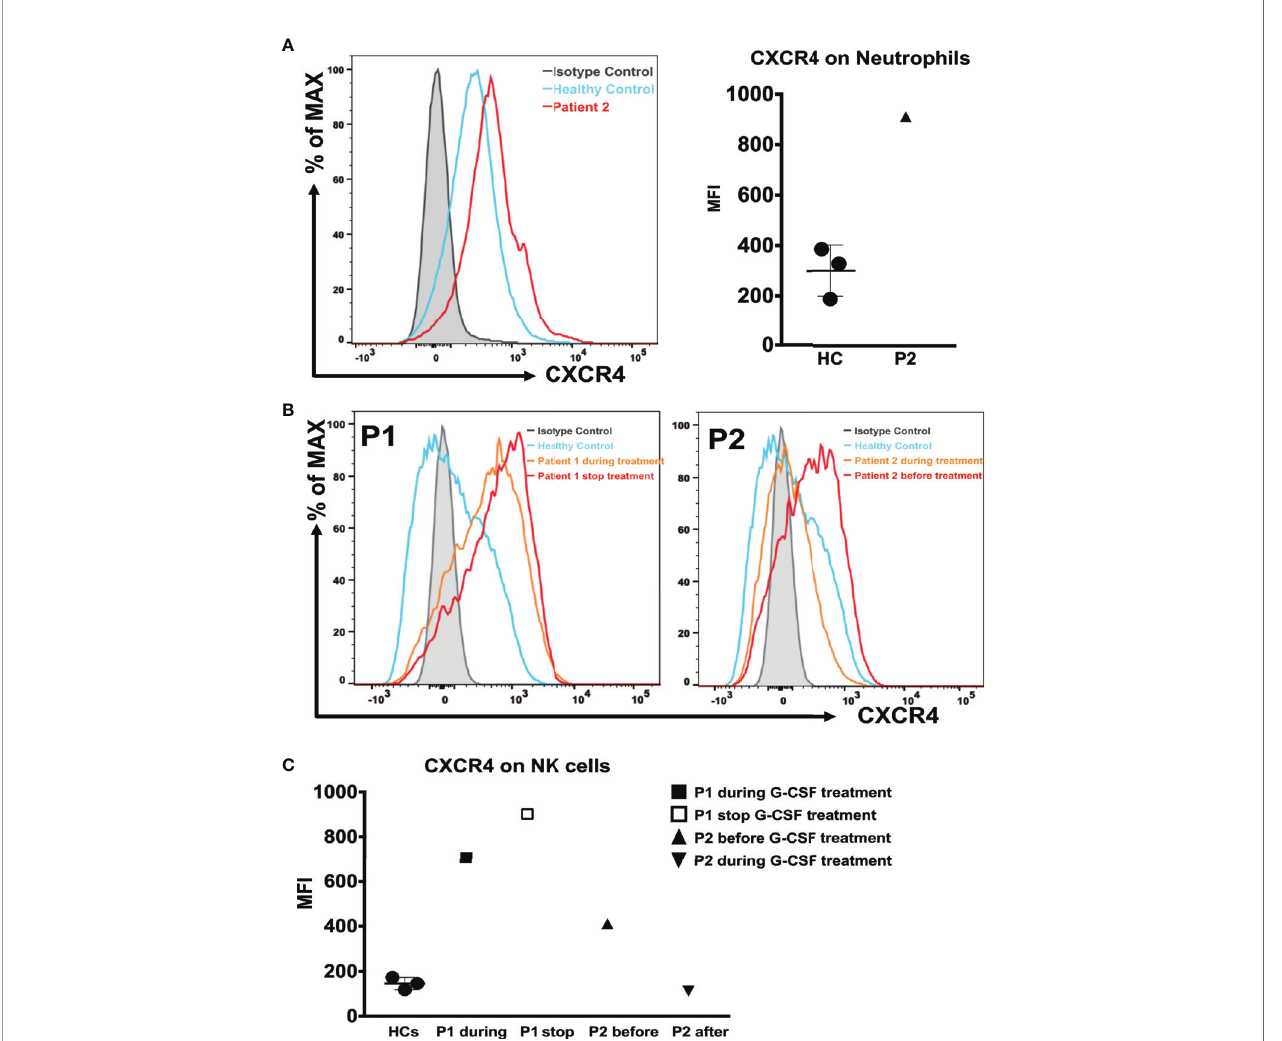
FIGURE 3 | CXCR4 expression on neutrophils and NK cells. (A) (Left) Representative histograms of neutrophils from patient 2 during G-CSF treatment and healthy controls. (Right) The mean fl uorescence intensity (MFI) of CXCR4 in neutrophils from patient 2 and healthy controls (n=3). (B) Representative histograms of NK cells from patient 1 during and after discontinuation of G-CSF treatment (Left), patient 2 before and during G-CSF treatment (Right), and healthy controls. (C) The MFI of CXCR4 on NK cells from patient 1 after discontinuation of G-CSF treatment, patient 2 before and during G-CSF treatment and healthy controls